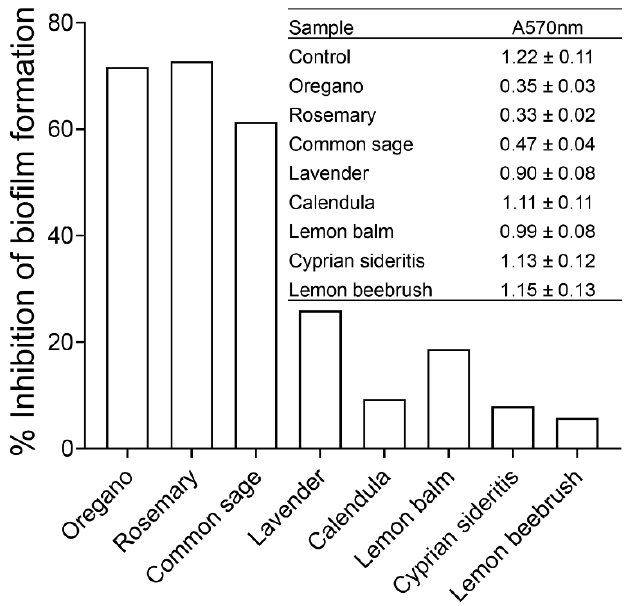
Figure 3. Effects of the ethanolic extracts from the eight aromatic plants from the flora of Cyprus on biofilm formation by E. coli MG1655 as quantified by crystal violet staining and measuring at A570 nm. Data are presented as the percentage of inhibition of biofilm formation compared to the control containing none of the ethanolic extracts . Inset: Absorbance values at 570 nm ± standard deviation following the crystal violet staining in three independent experiments .